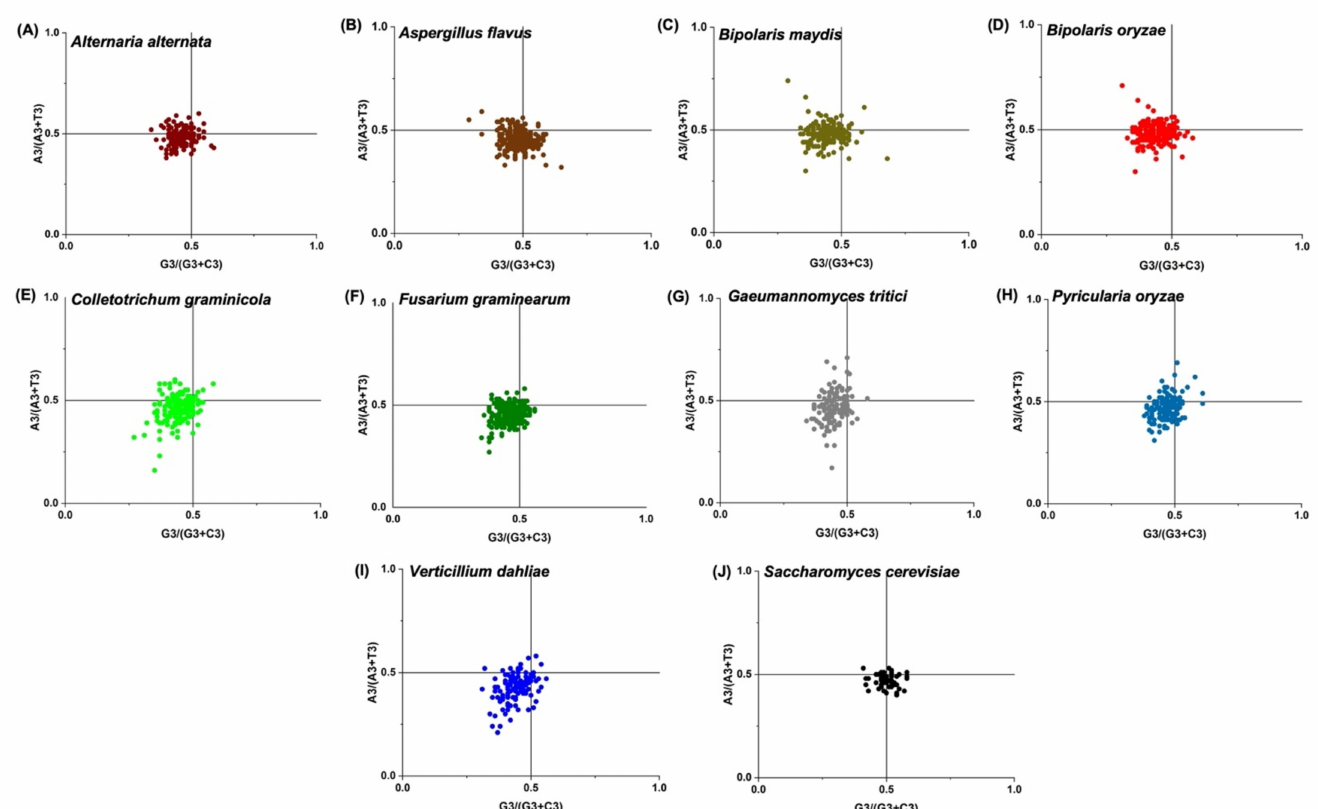
Figure 5. Parity rule (PR2)-bias plot analysis of zinc binuclear cluster coding sequences in Ascomycetes plant pathogenic fungi and model yeast